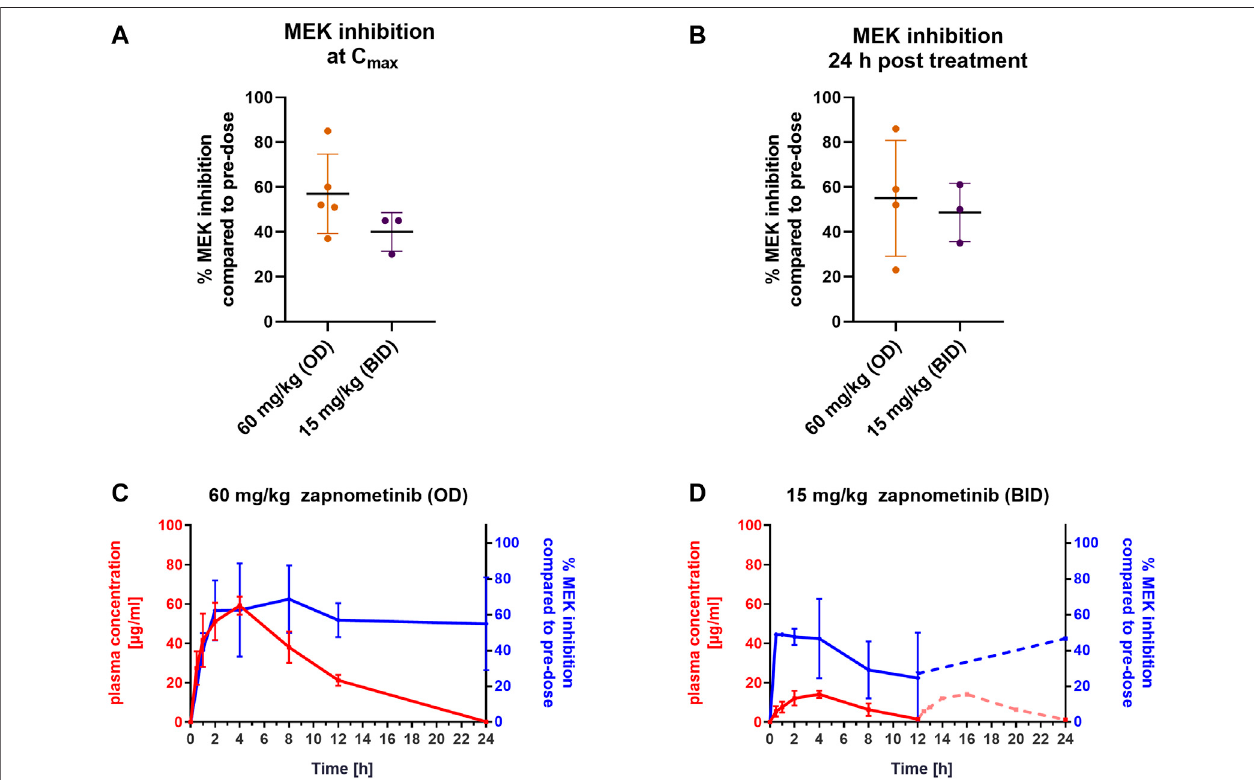
FIGURE2| Pharmacokineticsandpharmacodynamicsofzapnometinibinsyrianhamsters.Syrianhamstersweretreatedwitheitherasingledoseof60 mg/kgor twice daily with 15 mg/kg zapnometinib ( n = 5 animals per group). The fi rst treatment was given at t = 0 h and the second at 12 h post the fi rst treatment (only for 15 mg/kg). Blood was collected at pre-dose, and 0.5, 1, 2, 4, 8, 12, and 24 h after the fi rst treatment and analyzed for substance and ERK phosphorylation levels. Sincenodatawerecollectedbetween12and24 hthetheoreticalcourseofplasmaconcentrationwascalculatedbyaddingthevaluesfromthe fi rst12 htothe respective time points > 12 h (A,B) MEK inhibition in PBMCs compared to pre-dose at ( A ) C max ( t = 4 h; n (60 mg/kg) = 4; n (15 mg/kg) = 3) or (B) 24 h post treatment ( n (60 mg/kg) = 4; n (15 mg/kg) = 3). Data are presented as mean ± SD. (C,D) Plasma concentration (red line, left y -axis) of ( C ) 60 mg/kg and (D) 15 mg/kg of zapnometinib correlated with MEK inhibition (blue line, right y -axis). Dashed red line between 12 and 24 h shows extrapolated course of the plasma concentration and dashed blue line indicates that no values between 12 and 24 h were analyzed for MEK inhibition. Data are presented as mean ± SD ( n = 5).